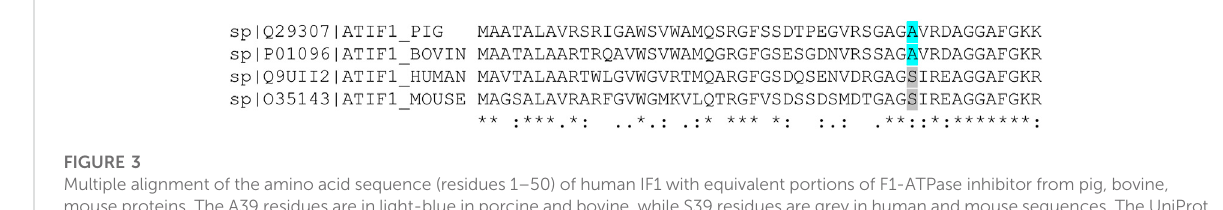
FIGURE 3 Multiple alignment of the amino acid sequence (residues 1 – 50) of human IF1 with equivalent portions of F1-ATPase inhibitor from pig, bovine, mouse proteins. The A39 residues are in light-blue in porcine and bovine, while S39 residues are grey in human and mouse sequences. The UniProt accessionnumbersforinhibitorproteinsfrom SusScrofa , Bostaurus , Homosapiens , Musmusculus ,areshownontheleftofeachsequence.Asterisk (*) indicates positions which have a single, fully conserved residue; colon (:) indicates conservation between amino acid groups or similar